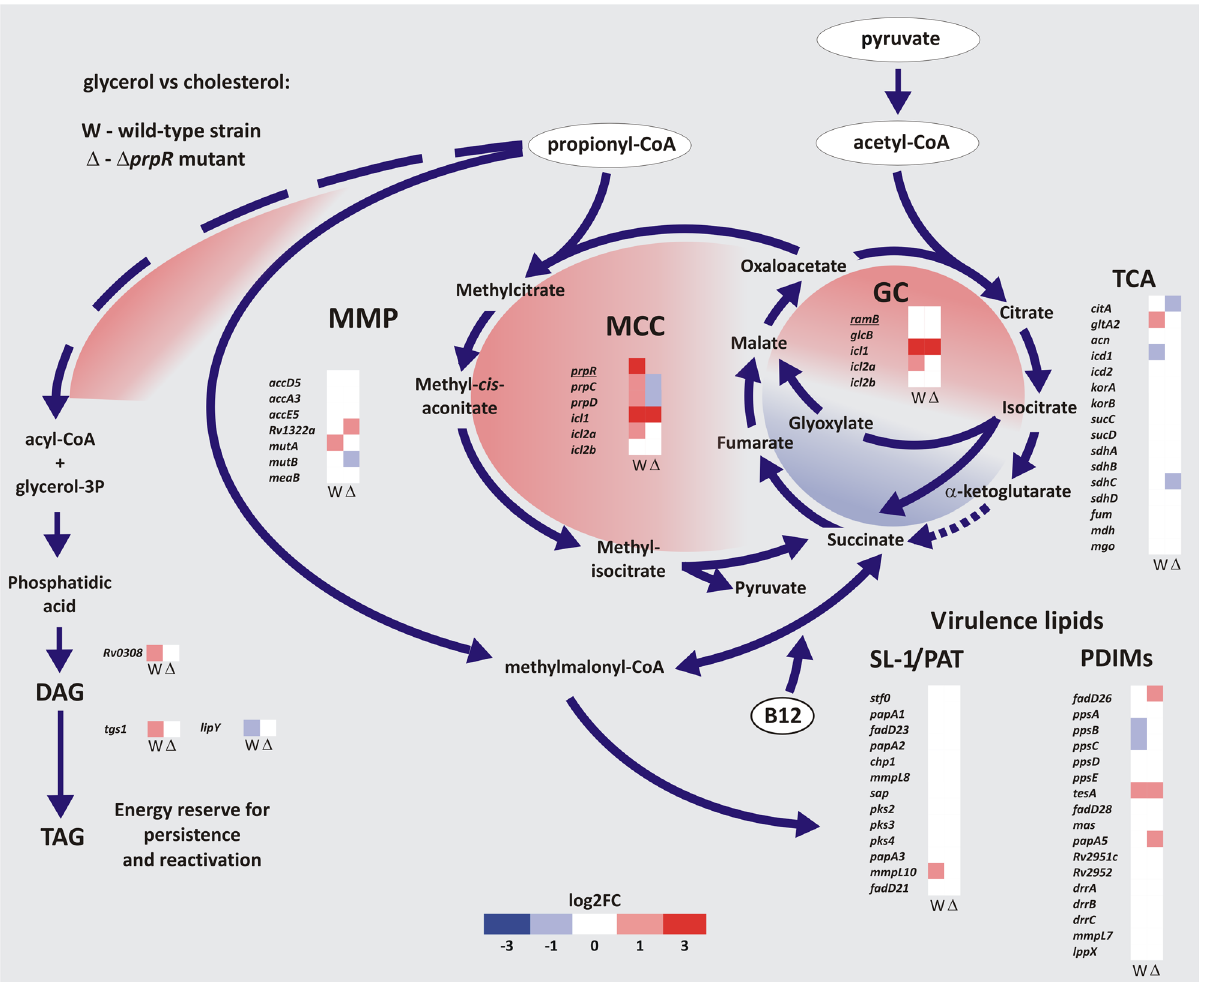
Figure 4. Transcriptional response of Mtb intermediary metabolism in channeling cholesterol degradation metabolites when cholesterol is utilized as a sole carbon source. DGE analysis of the main pathways of acetyl- CoA, propionyl-CoA, and pyruvate amelioration in Mtb and ∆ prpR mutant. The two datasets represent DGE analysis comparing growth in glycerol vs cholesterol of the Mtb wild-type strain (W) and Δ prpR mutant (∆). Transcriptional changes that were not cholesterol-specific (were present also in standard 7H9/10% OADC medium) were excluded from the analysis. See the color key for log2FC values. TCA tricarboxylic acid cycle, GC glyoxylate cycle, MCC methylcitrate cycle, MMP methylmalonyl pathway. Up-regulated and down-regulated pathways are shown in red and blue,